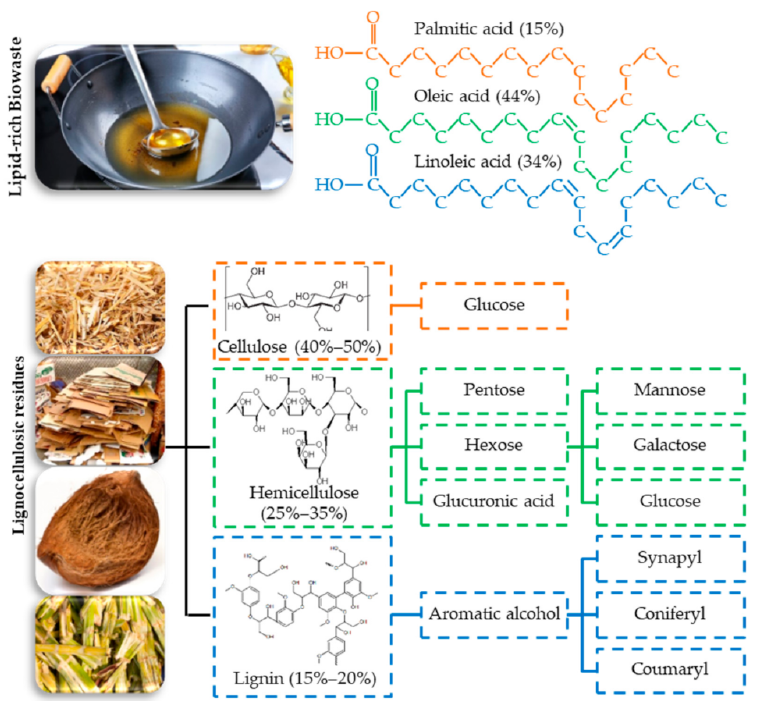
Figure 1. Representation of the chemical structure and composition of the main compounds in lipid-rich biowaste (WCO) and lignocellulosic residues. Table 2. Biopolymers distribution in various lignocellulosic residues. Lignocellulosic Residue Cellulose (wt.%) Hemicellulose